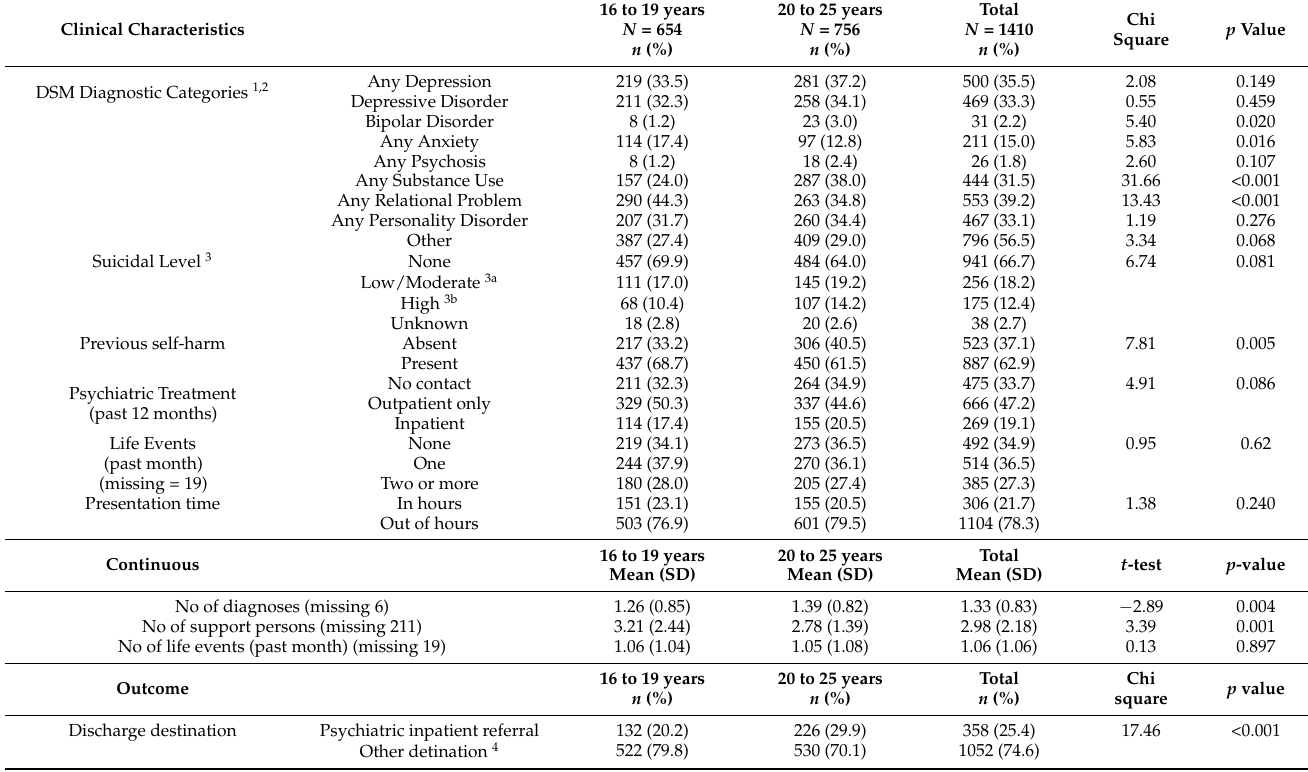
Table 2. Clinical characteristics by age strata (Adolescents vs. Young